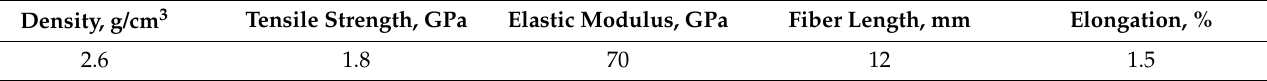
Table 6. Physical and mechanical characteristics of glass fiber.